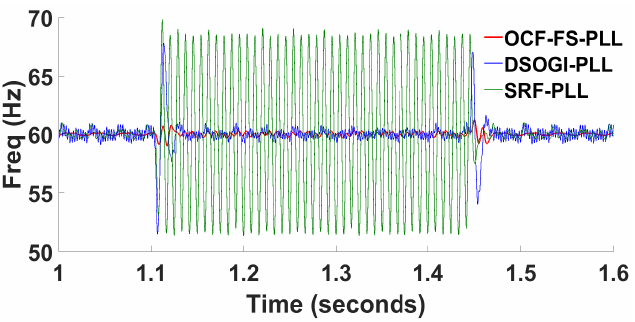
Figure 9. Grid frequency during unbalanced grid voltage sag in 2 phases.